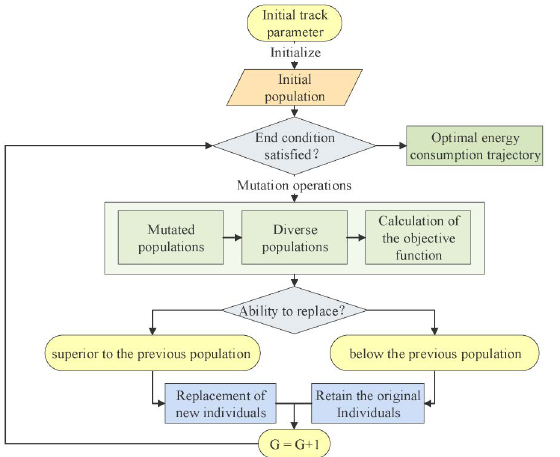
Figure 5. Initial track parameter variation, crossover, and selection form optimal